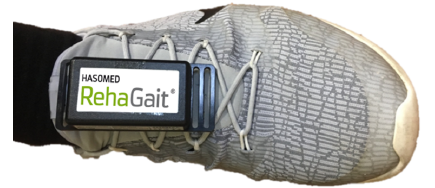
Figure 14. Sensor position: dorsum of the foot.